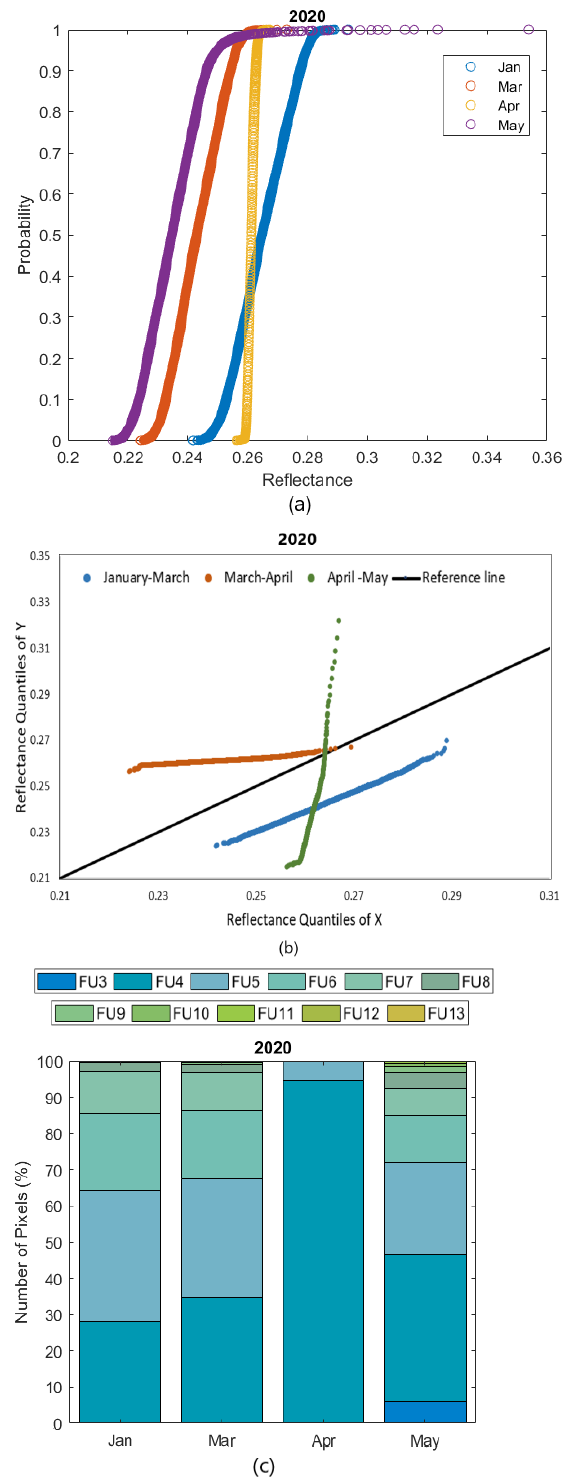
Figure 4. Comparison of B2 surface reflectance and FUI for months January, March, April, and May in year 2020. ( a ) ECDF for B2 SR; ( b ) Q–Q plot for B2 SR (X: Previous month image; Y: Current month image); ( c ) Stacked bar chart showing FUI (number of pixels